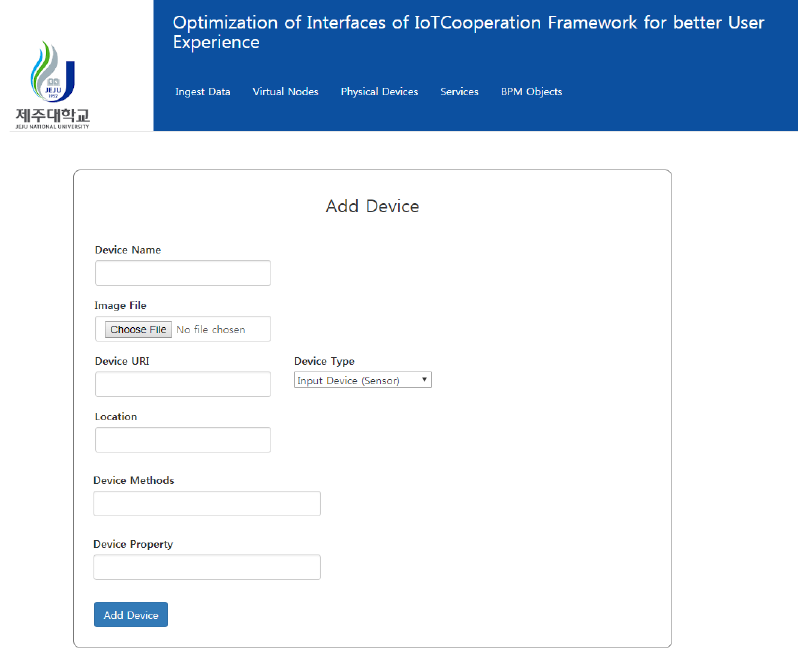
Figure 10. Interface for adding a